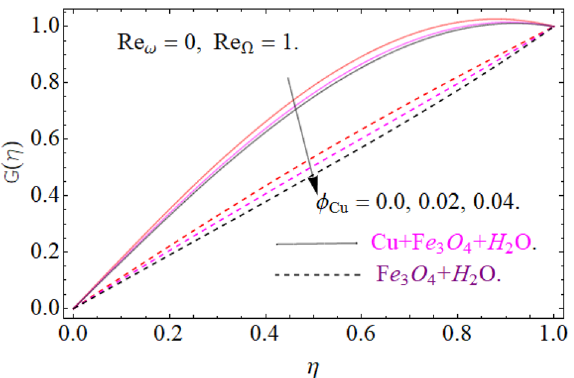
Figure 7. Impression of φ Cu on G( η ), When M = 0.2, φ Fe 3 O 4 = 0.04, Ec = 0.1, Pr = 6.2 .